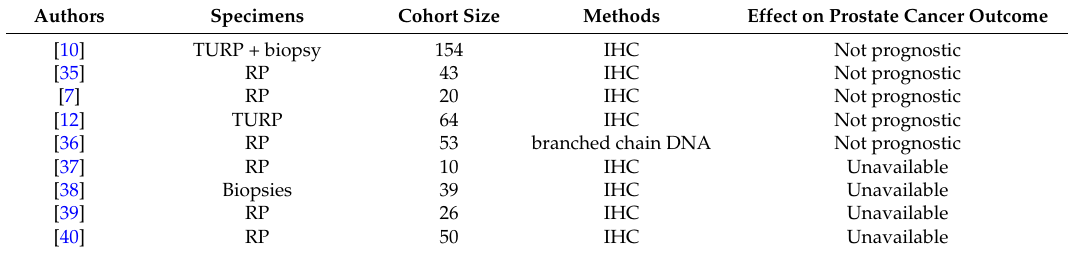
Table 2. Expression of AR in cancerous stroma and association with patient outcomes. RP =